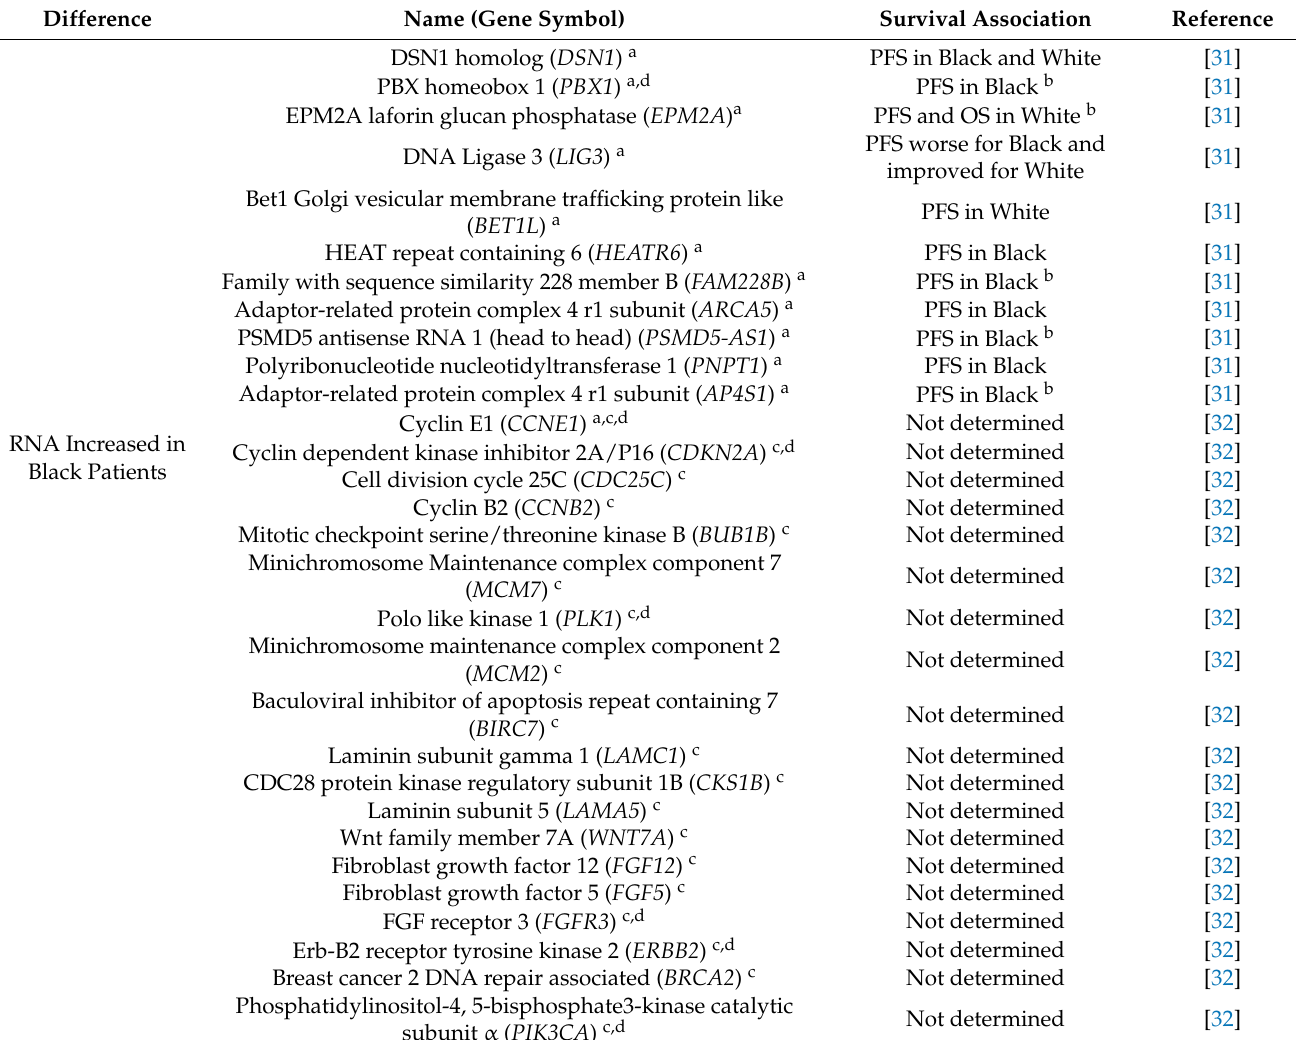
Table 1. Molecules significantly associated with race and